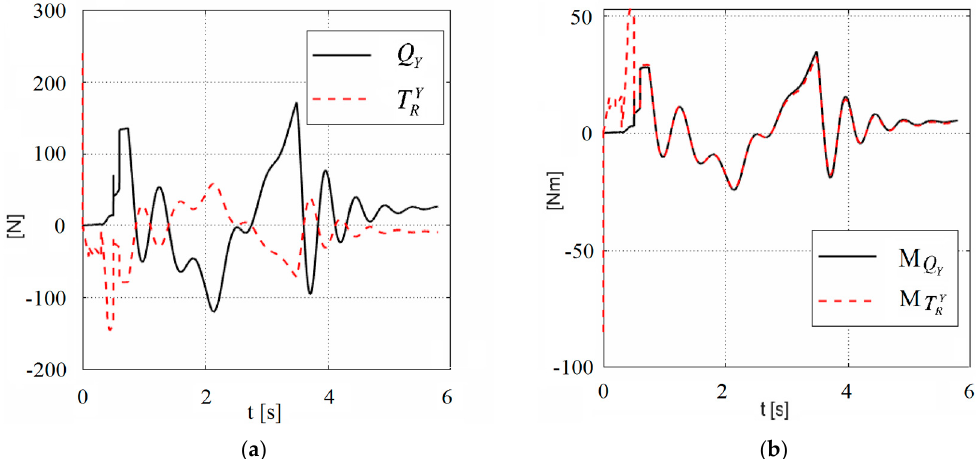
Figure 8. The performed angles of the flight control in the channel of altitude and direction.